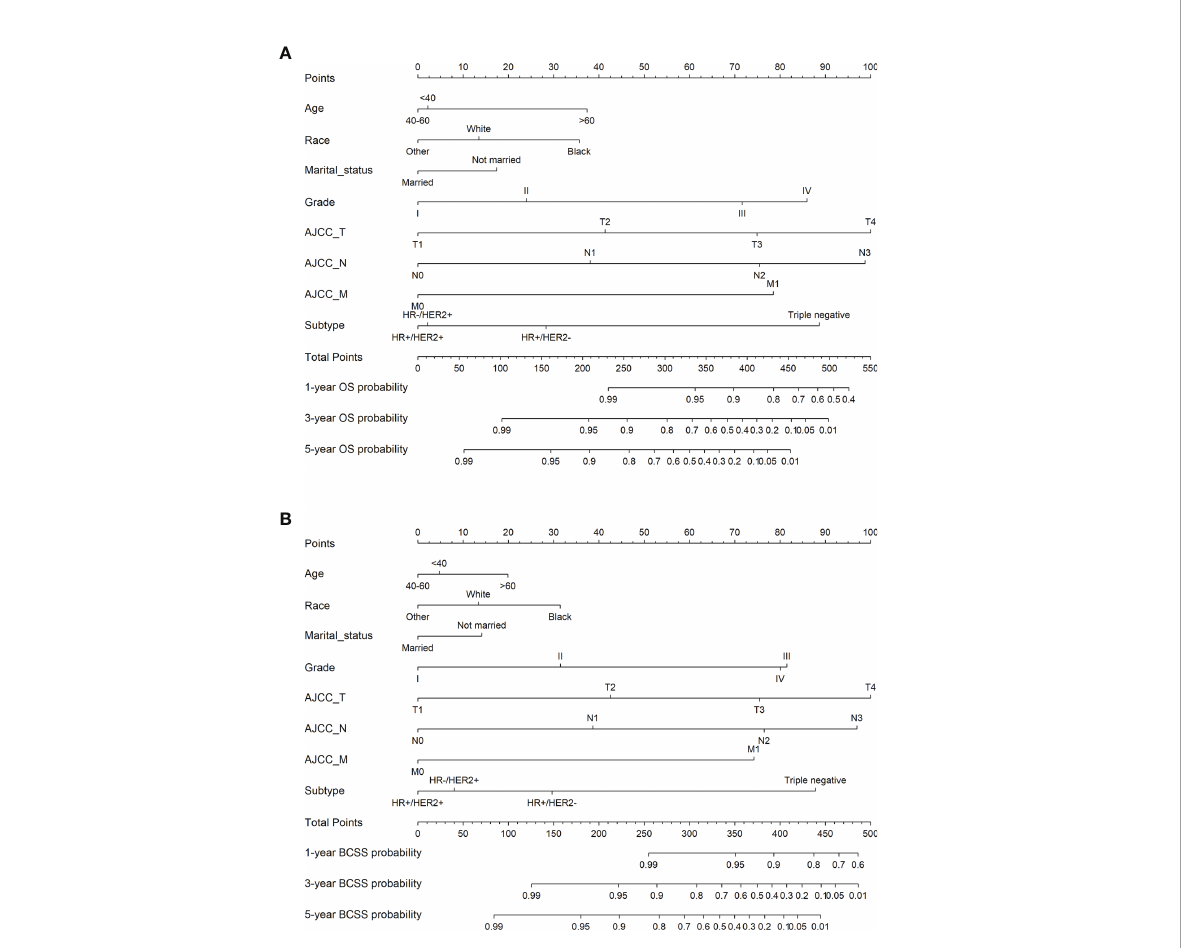
FIGURE 9 1-, 3-, 5-year probability prediction of overall survival (A) and breast cancer speci fi c survival (B) in non-radiotherapy patients. OS, overall survival; BCSS, breast cancer-speci fi c